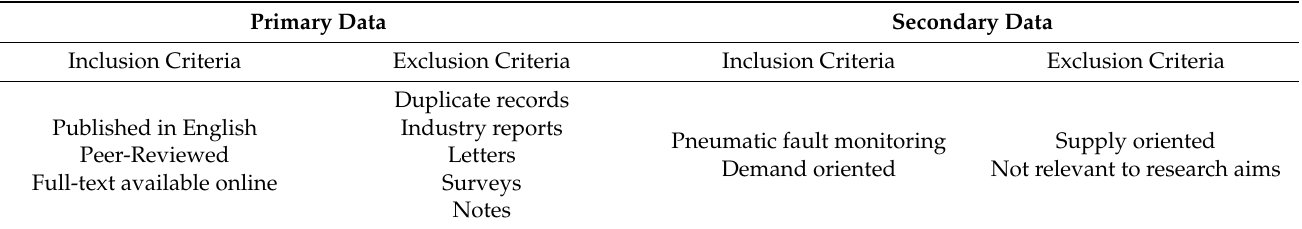
Table 2. The criteria followed during the selection